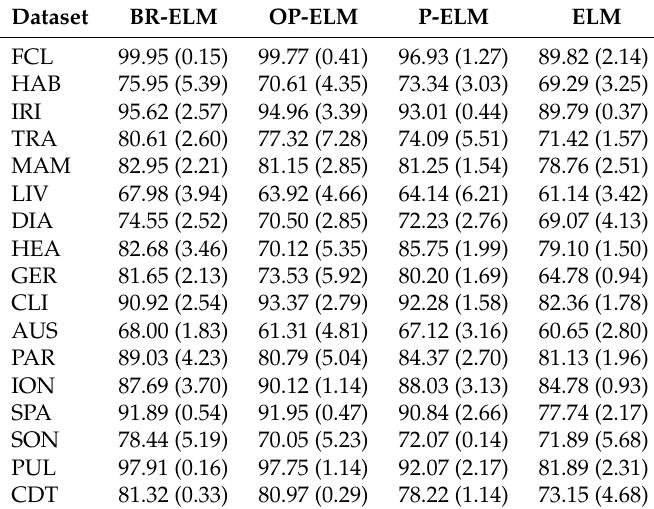
Table 5. Accuracies of the model in the tests